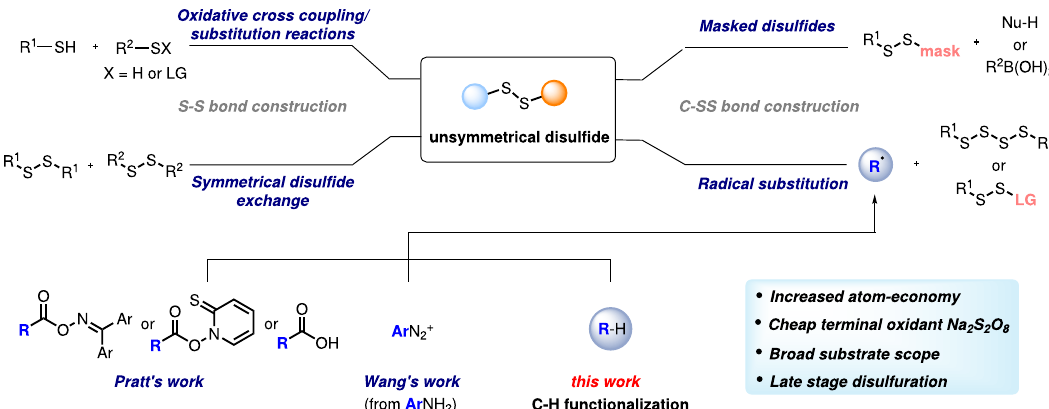
Fig. 2 State of art methods for the preparation of unsymmetrical disul fi des. Reported methods for preparation of unsymmetrical disul fi des and this work.